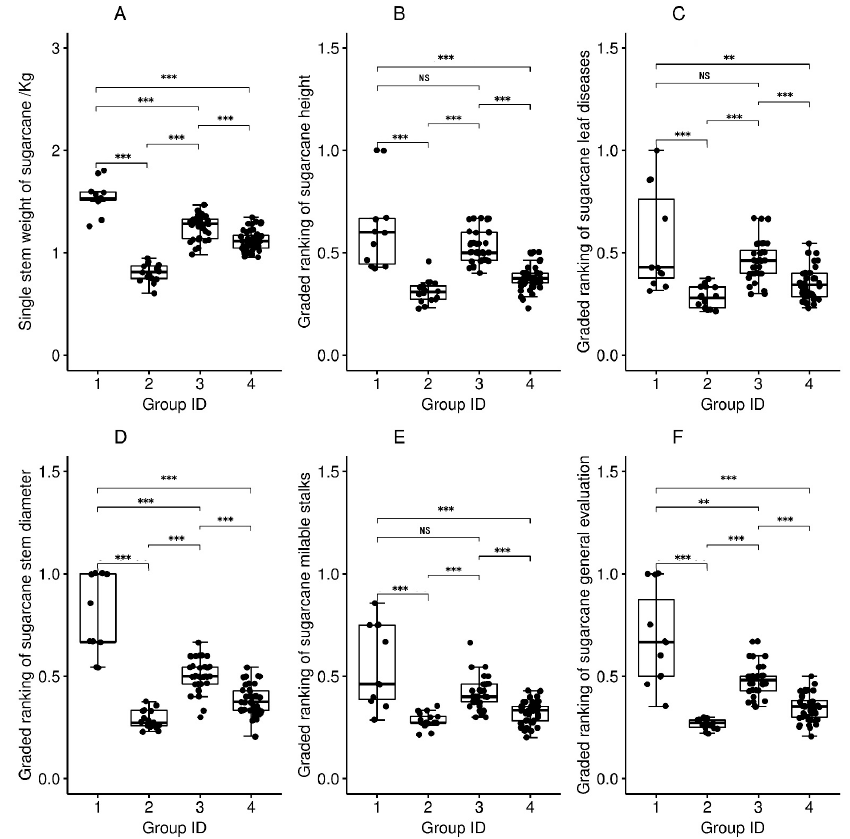
Figure 2. Differences in agronomic characteristics between the four cluster groups. Comparisons of ( A ) single-stem weight, ( B ) height, ( C ) leaf disease incidence, ( D ) stem diameter, ( E ) millable stalk count, and ( F ) general vigor are shown based on grading data of each cluster-variety group. Not significant (NS), p > 0.05; **, p < 0.01; ***, p < 0.001 by LSD. In contrast, analysis of industrial characteristics among the four groups revealed no significant differences in terms of brix, juice sucrose, cane sucrose, fiber, and gravity pu- rity ( p > 0.05; Figure 3).